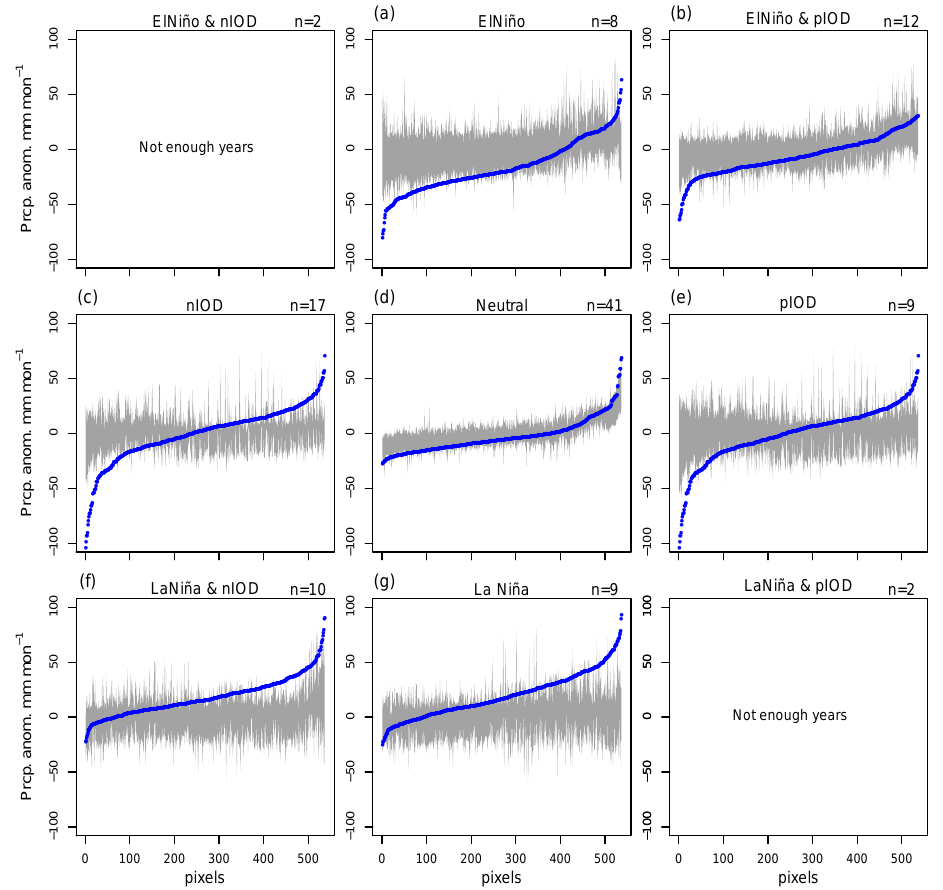
Figure 2. Composite of the mean precipitation anomaly for June–October for each pixel in the basins when El Niño, La Niña, and positive or negative IOD occurred, co-occurred, or did not develop. The number of observed years for each ENSO–IOD combination is indicated with n . Combination-specific precipitation anomalies (mmmonth − 1 ) are shown with blue dots, 10 and 90% lower and upper bounds of the pixel-specific long-term mean precipitation as determined by Monte Carlo testing and a two-tailed t test at 80% confidence level is shown with gray shading. Where the blue dots lie outside the gray shaded area, the precipitation anomaly values are significantly different from the long-term